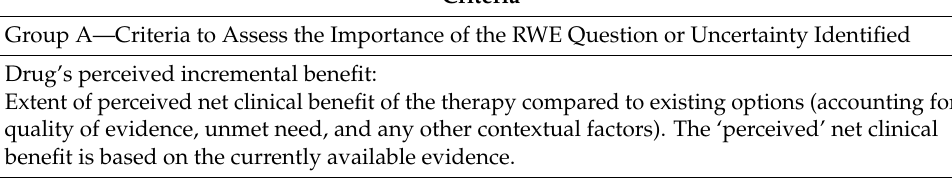
Table A1. Initial set of MCDA criteria.